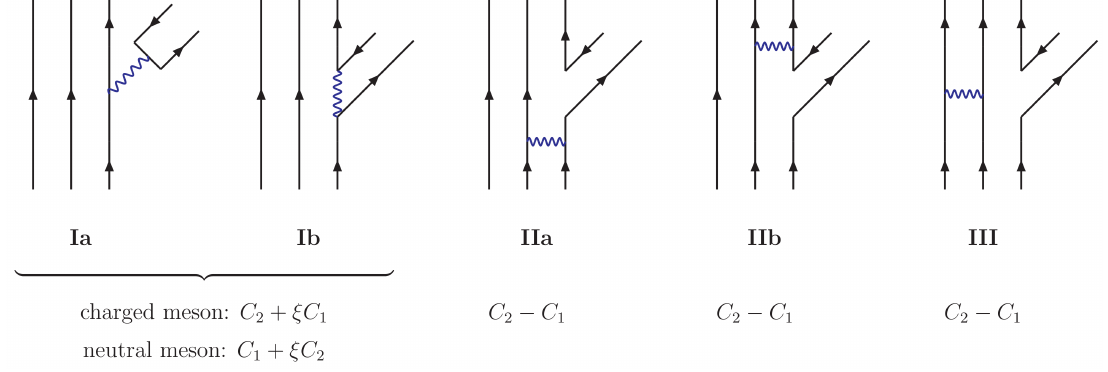
Figure 1. Flavor-color topologies of nonleptonic two-body